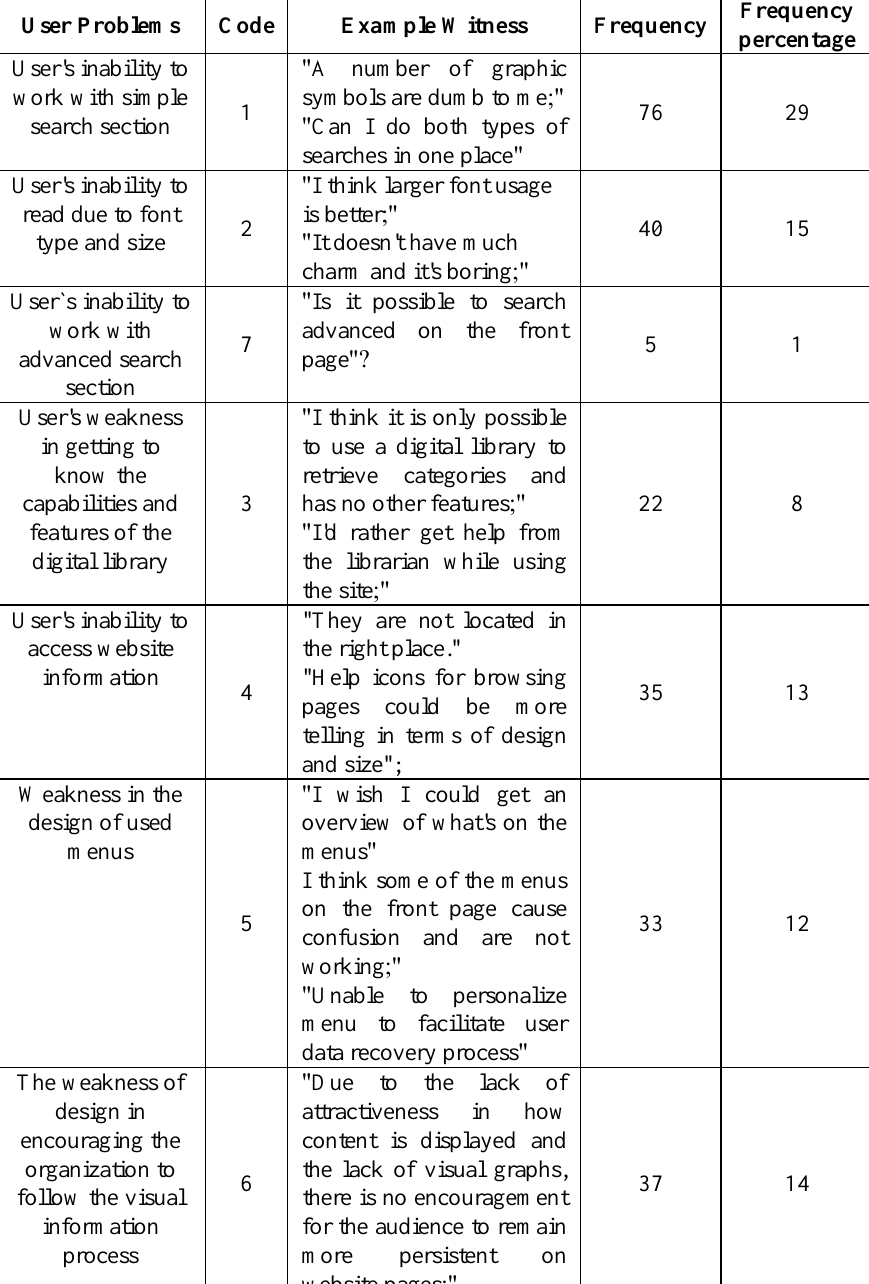
Table 6 - Codes of Visual Elements